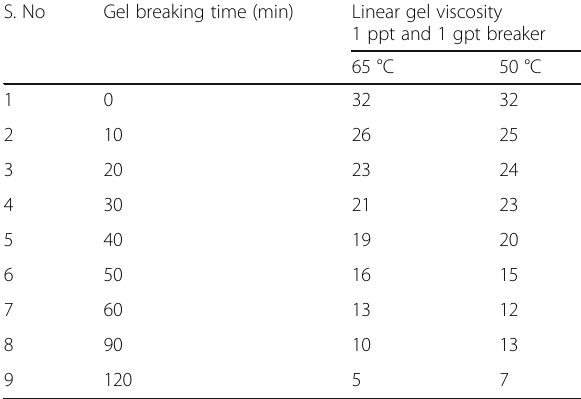
Table 2 Test-2 breaker test result (7.5 gpt gel under